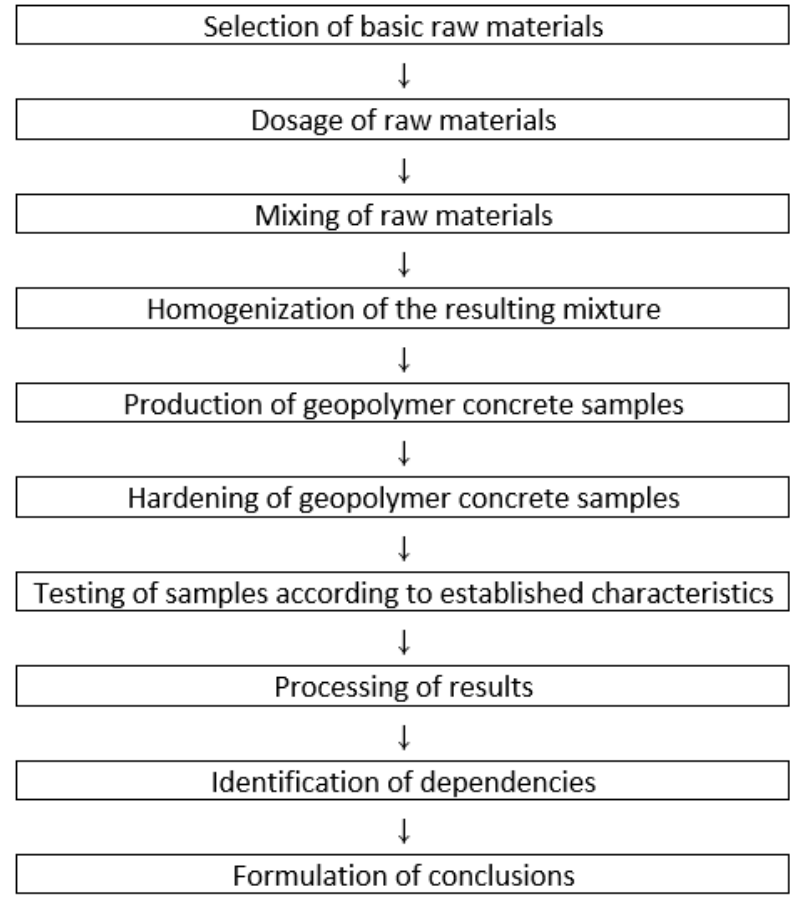
Figure 4. Step-by-step algorithm of the research methodology.